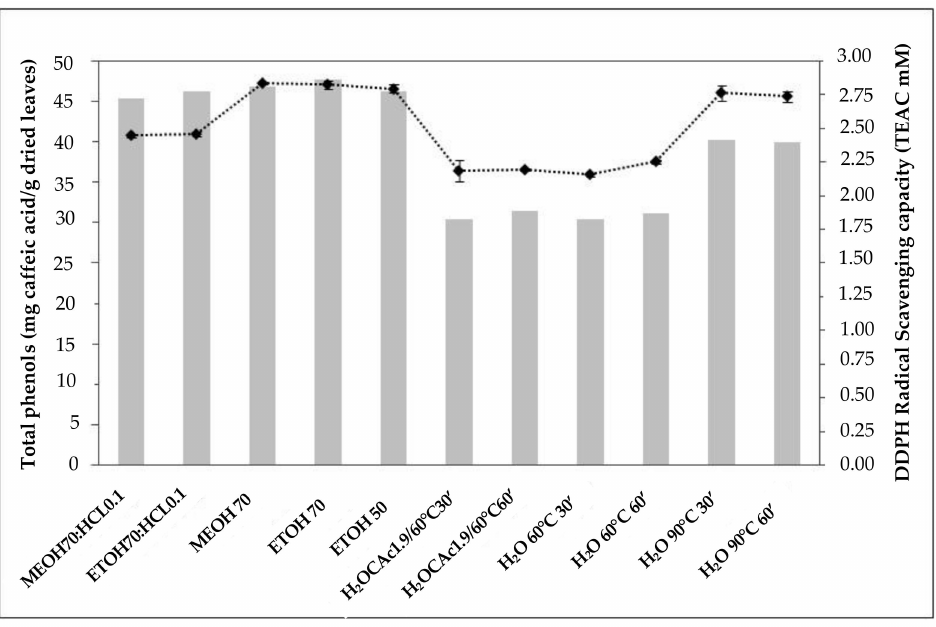
Figure 1. Total phenolic content and DPPH scavenging radical activity of different types of olive leaf extracts.